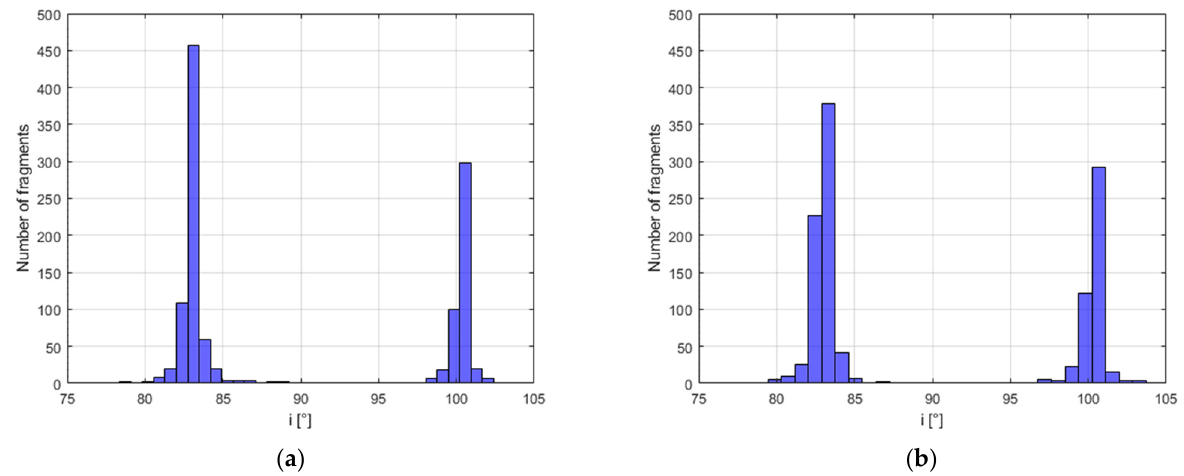
Figure 8. Histograms of reference ( a ) and estimated ( b ) fragments in range [75°, 105°] of inclination for first test case.